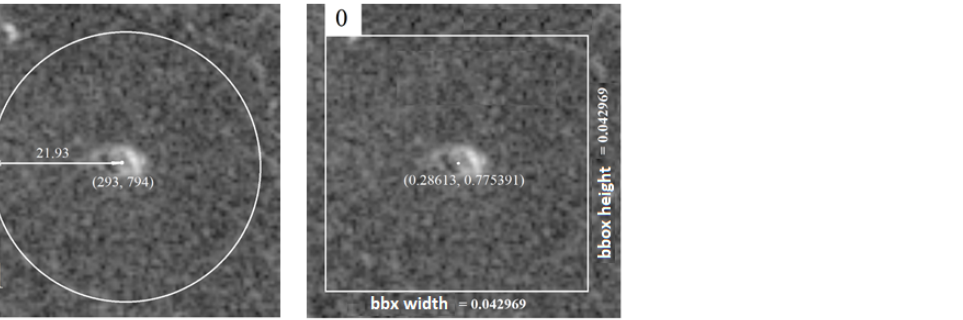
Figure 5. Difference between Magellan ( left ) and YOLO ( right ) annotations.